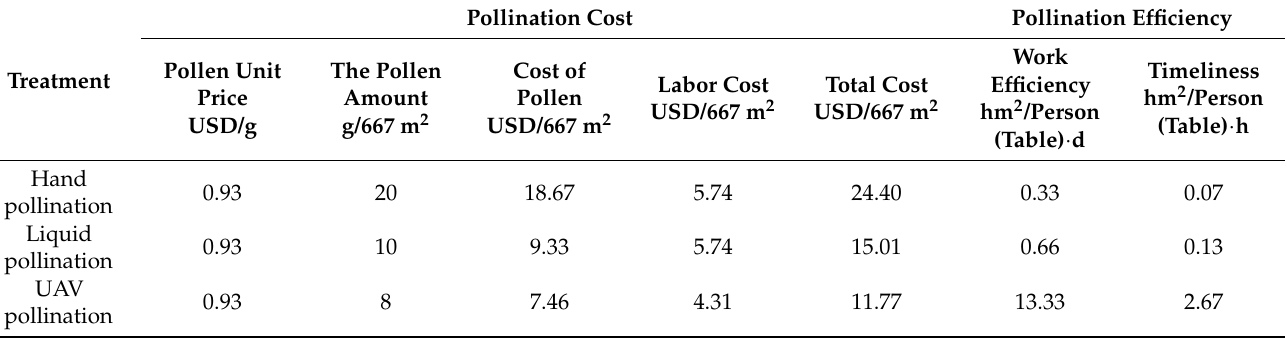
Table 4. Analysis of pollination cost and efficiency per unit area of different pollination methods of ‘Kuerle